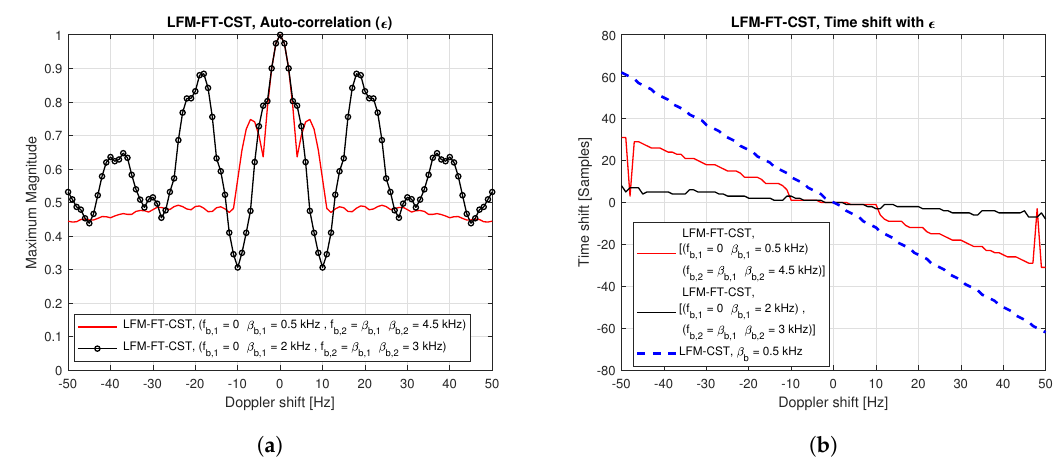
Figure 4. Auto-correlation of LFM-FT signal in the presence of Doppler shift: maximum magnitude and time shift. ( a ) Maximum magnitude vs. Doppler shift; ( b ) Time shift vs. Doppler